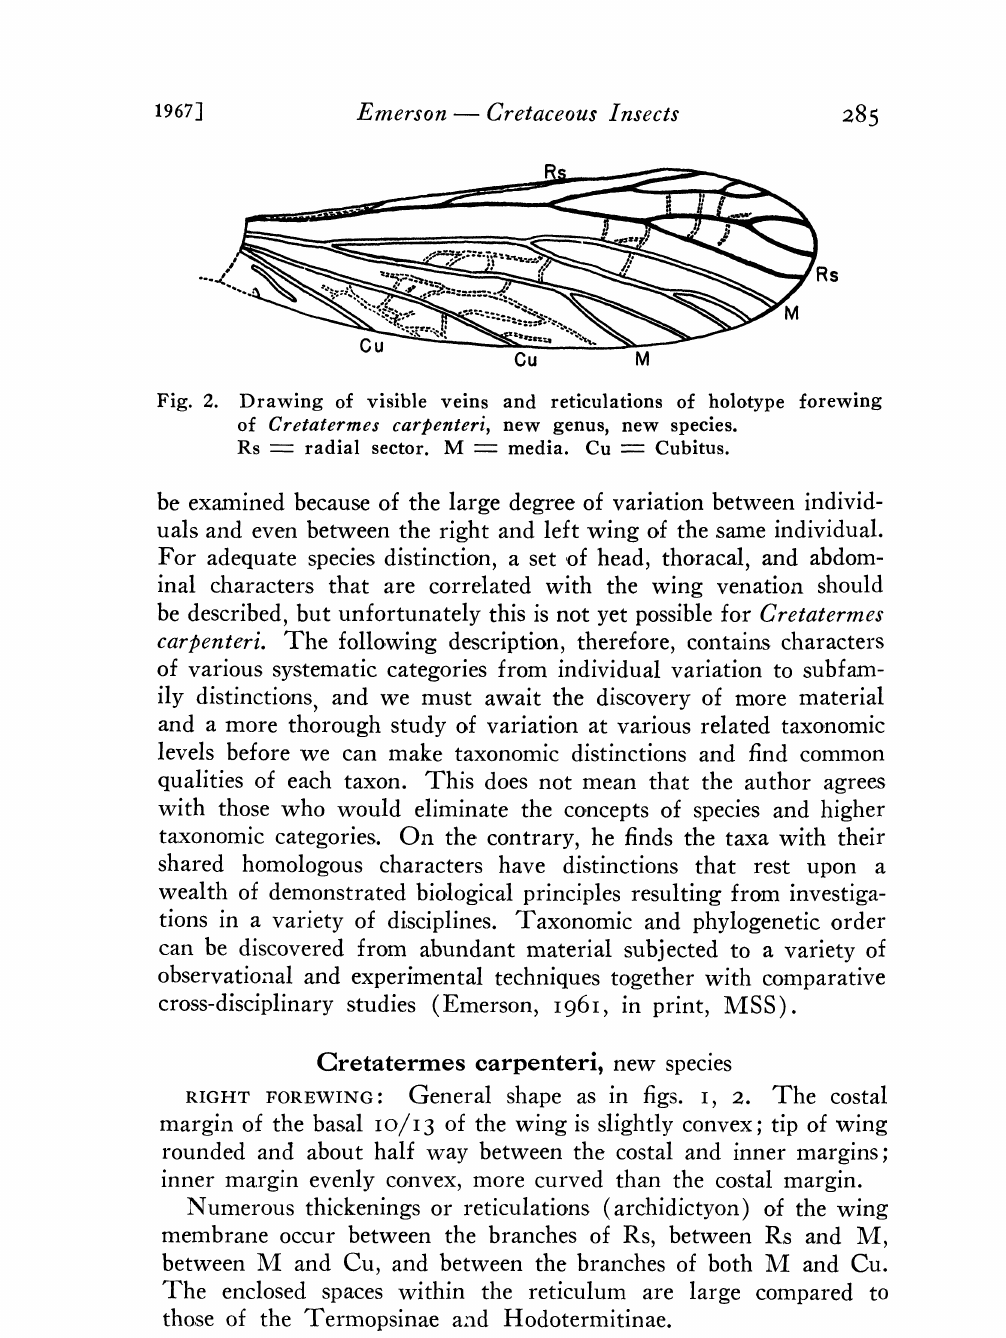
Fig. 2. Drawing of visible veins and reticulations of holotype f.orewing of Cretatermes carpenteri, new genus, new species. Rs radial sector. M media. Cu